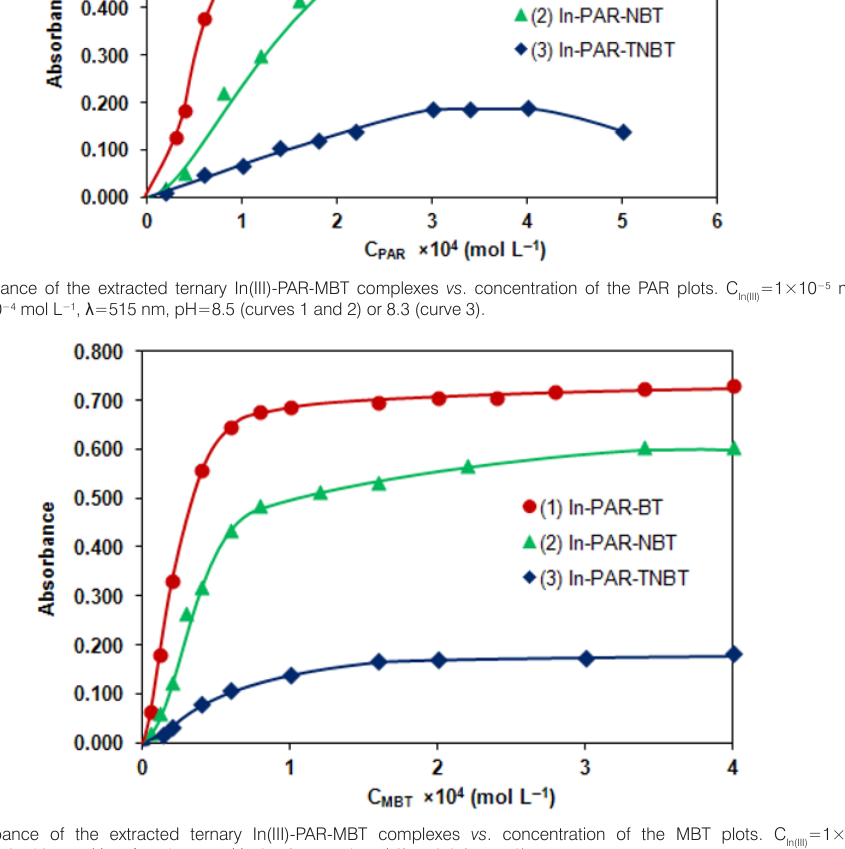
=1×10 −5 mol L −1 , In(III)